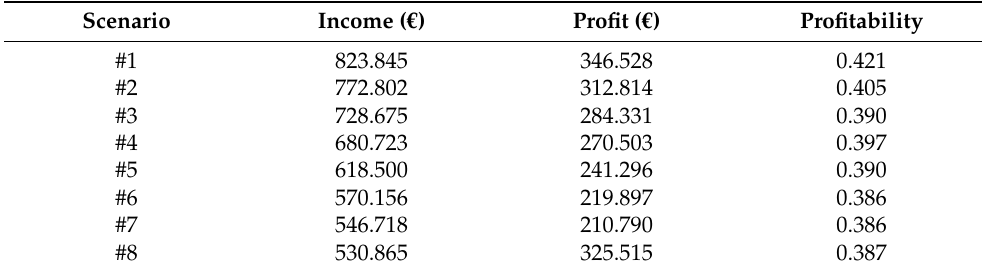
Table 8. Income, profit, and profitability for the various scenarios for 9 October 2019.